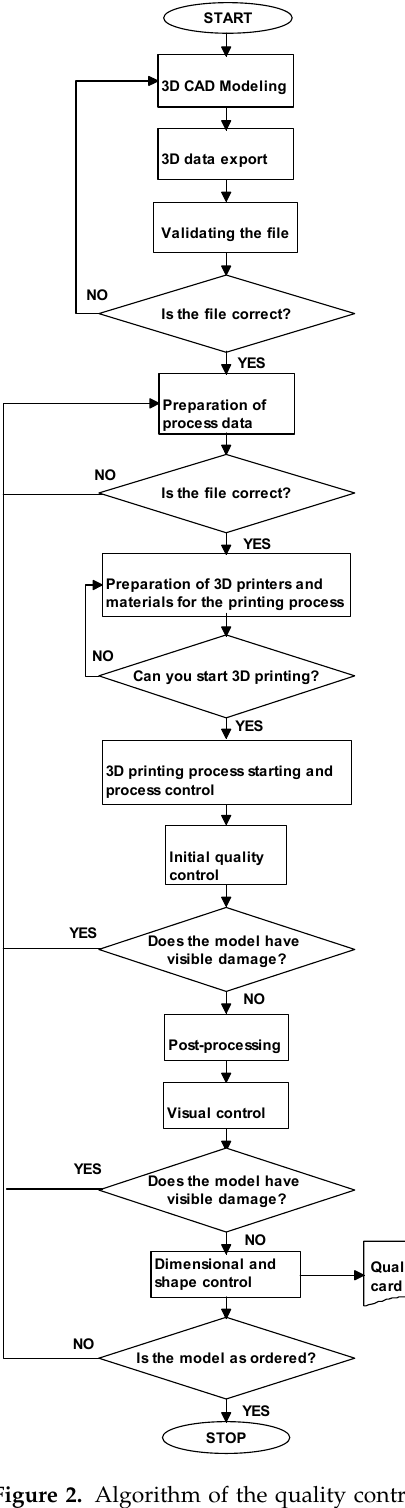
Figure 2. Algorithm of the quality control process for models that are directly connected to the manufacturing process.